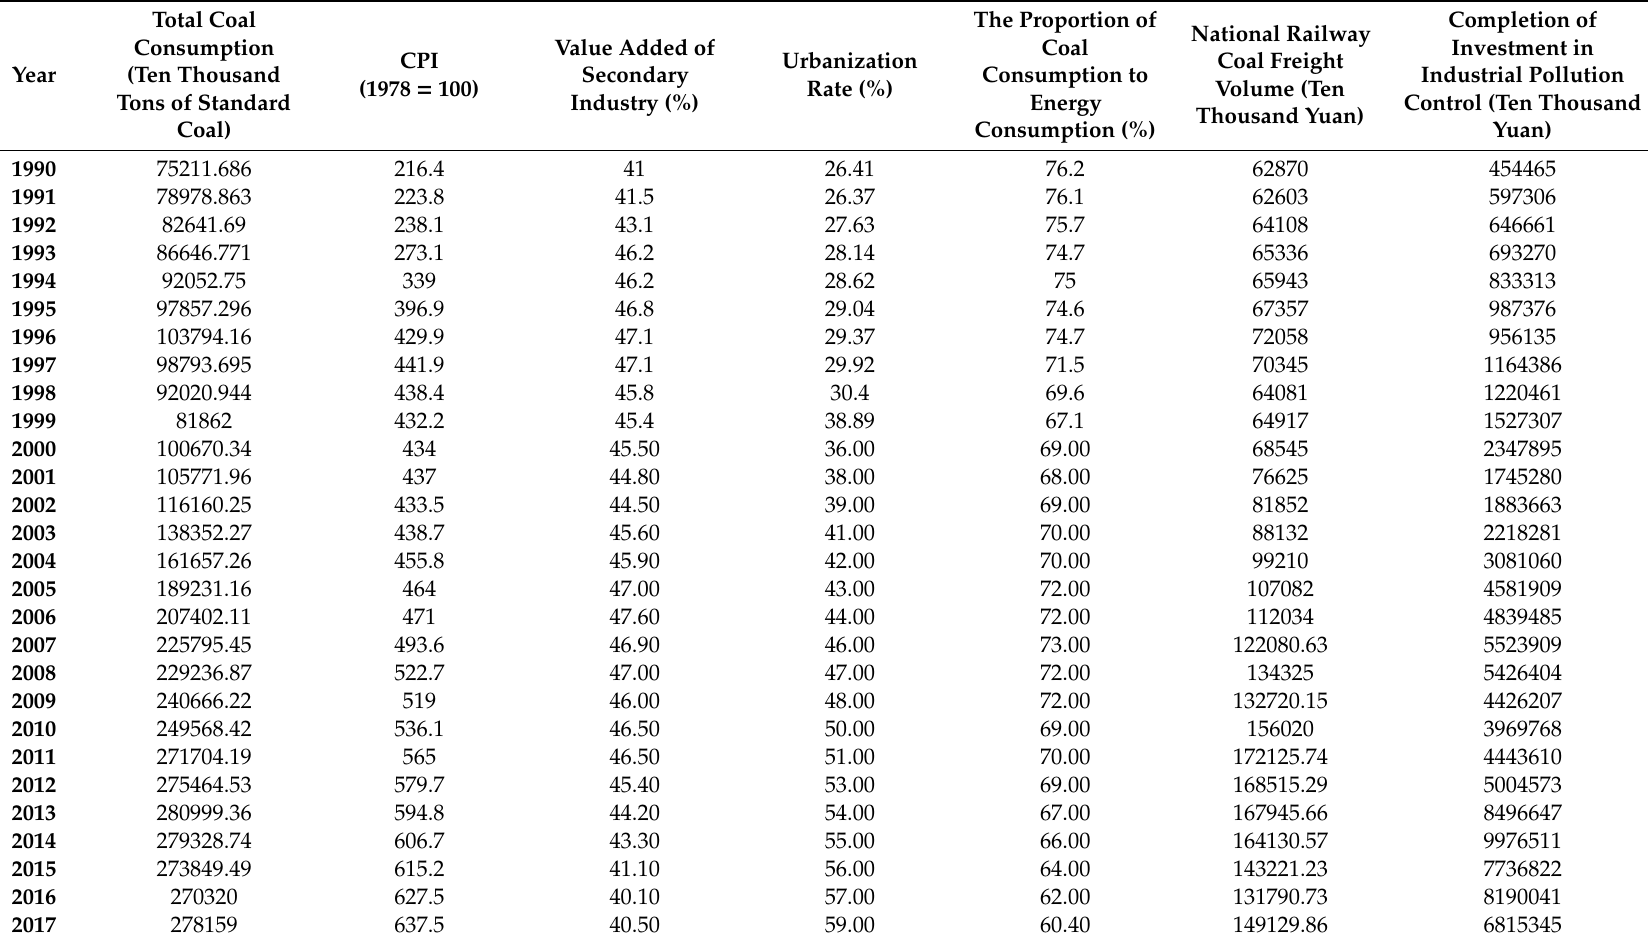
Table 2. Data of the main influencing